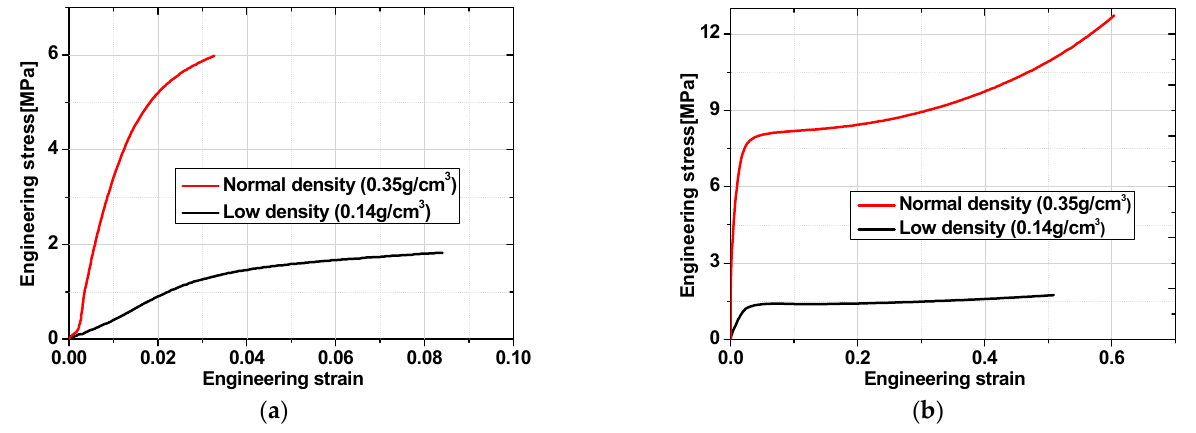
Figure 4. Experimental stress-strain curves in: ( a ) tensile test; ( b ) compressive test.